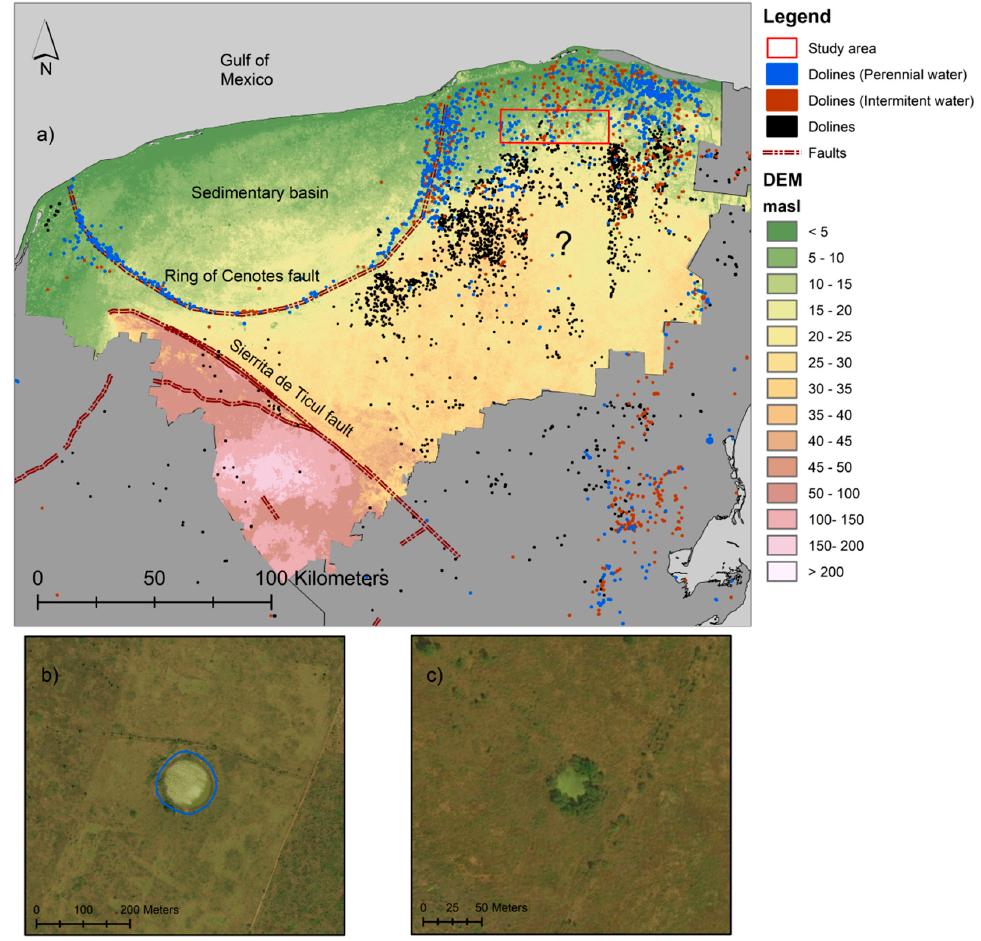
Figure 3. ( a ) Elevation, dolines distribution from contour maps at 1:50,000 scale and the study area in Yucatan; notice the evident lack of data in a central area surrounded by a high doline density due to probable misclassification; ( b ) a doline correctly mapped by contour maps in the study area; ( c ) one of several dolines not included by contour maps.